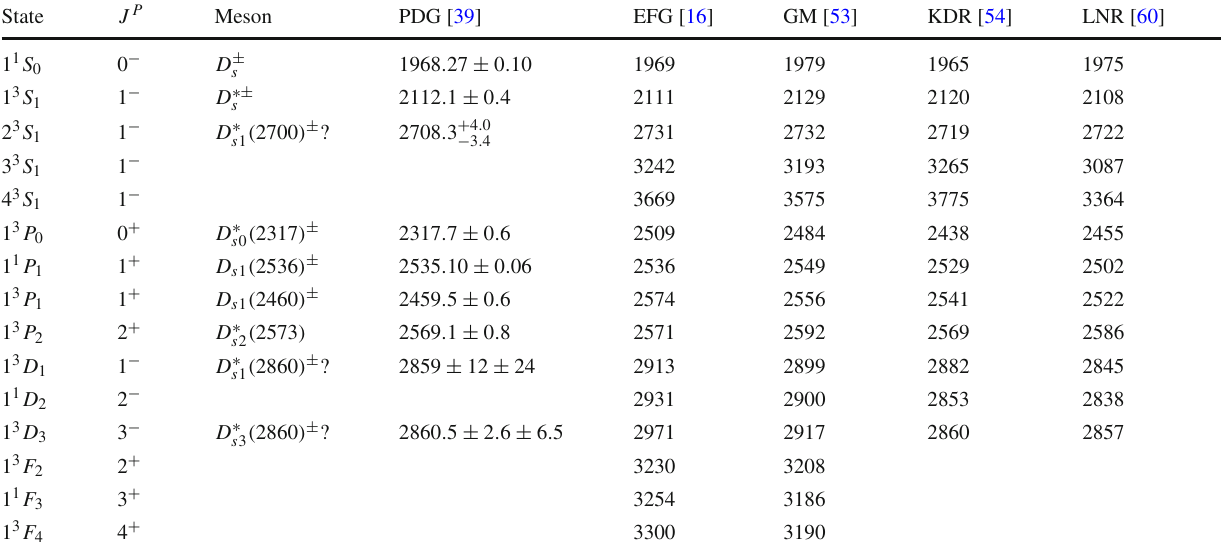
are from Ref. [39]. The dashed lines are the fitted Regge trajectories for the theoretical values in [60] while the solid line is for the experimental data from